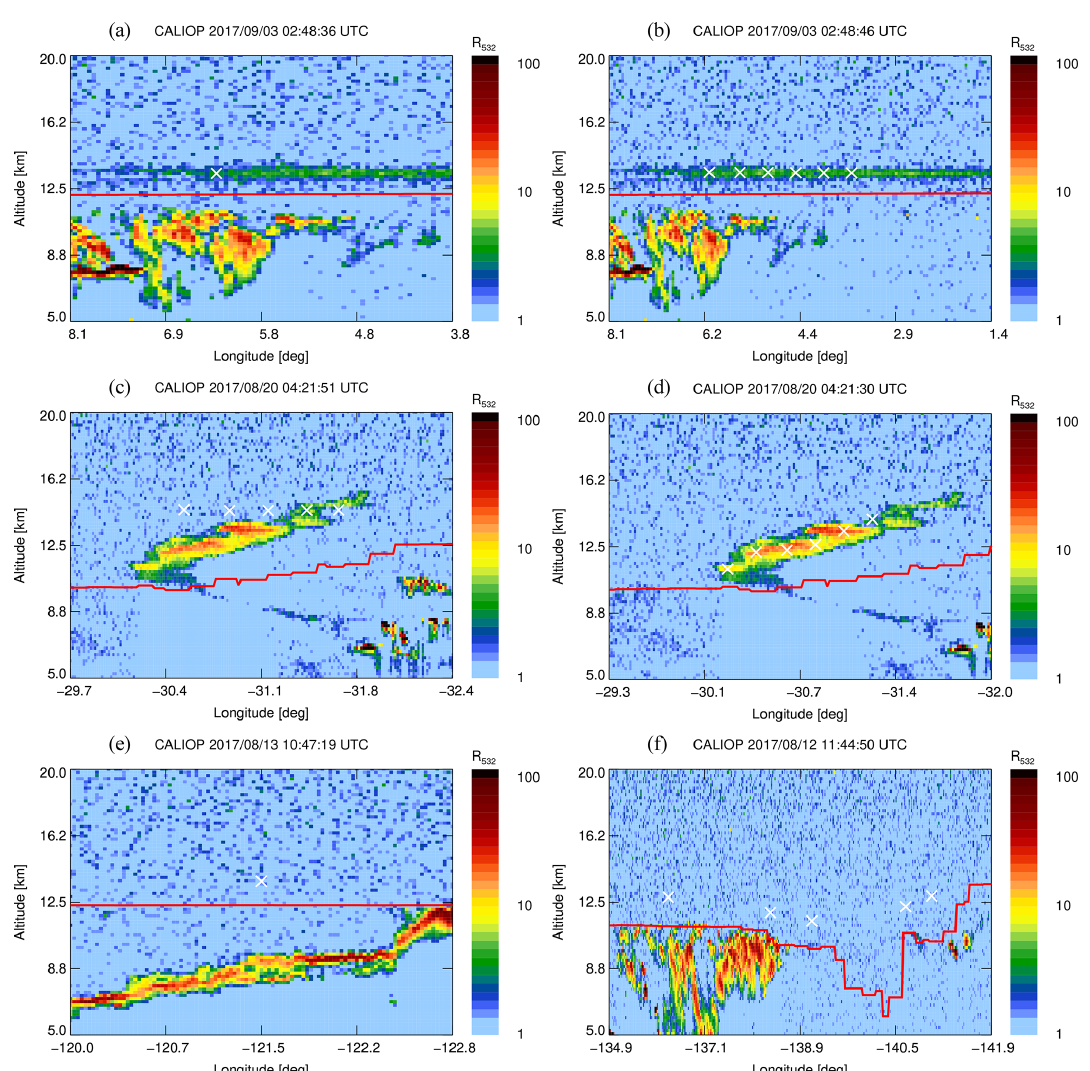
Figure 2. Altitude–longitude plot with CALIOP backscatter ratio and back-trajectory results. The red line indicates the thermal tropopause from CALIOP. (a) A match on 3 September between CALIOP and the lower CLaMS back trajectory starting on 4 September, indicated by the white cross. The distance between the back-trajectory result and the plotted white cross is 47km. (b) Newly initialized back trajectories on 3 September (white crosses). (c) The matches on 20 August, between CALIOP backscatter and the results from the back trajectories initialized on 3 September, where the distance between back trajectory result and CALIOP overpass is smaller than 250km. Note the altitude discrepancy showing that the vertical displacement is not precisely reproduced in the model. (d) Newly initialized back trajectories on 20 August. (e) Match location on 13 August with a vertical distance of 3km to the aerosol plume. (f) Match location on 12 August with no clear correspondence between the trajectory and the enhanced backscatter from CALIOP. The time of the location match is well before the fires, 21:00UTC (Peterson et al.,